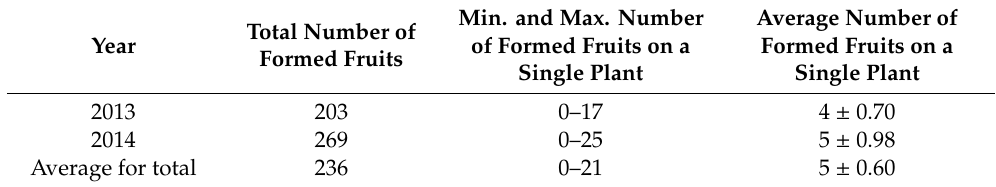
Table 3. Characteristics of fruit forming of C. calyculata in the examined population in subsequent years. Values with ± SE are